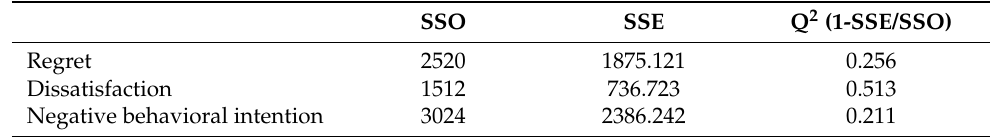
Table 7. The results of predictive